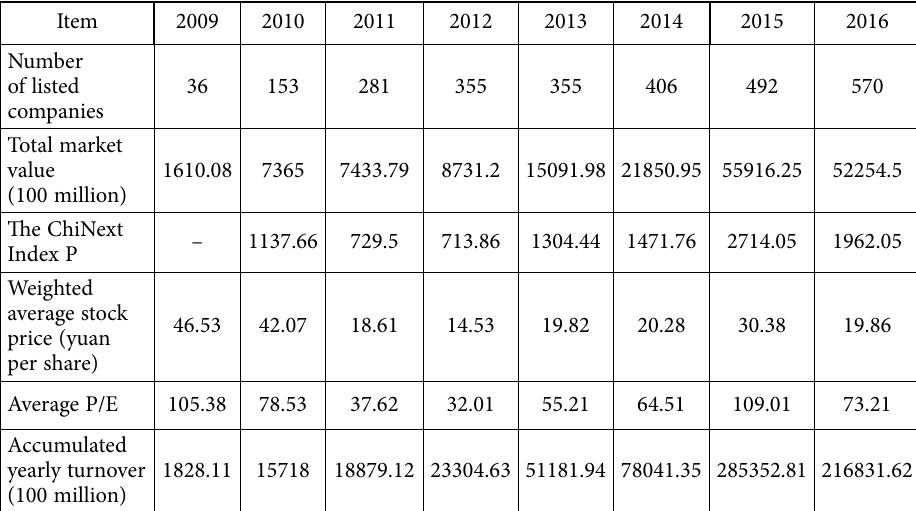
Table 1. Basic information of the ChiNext market from 2009 to